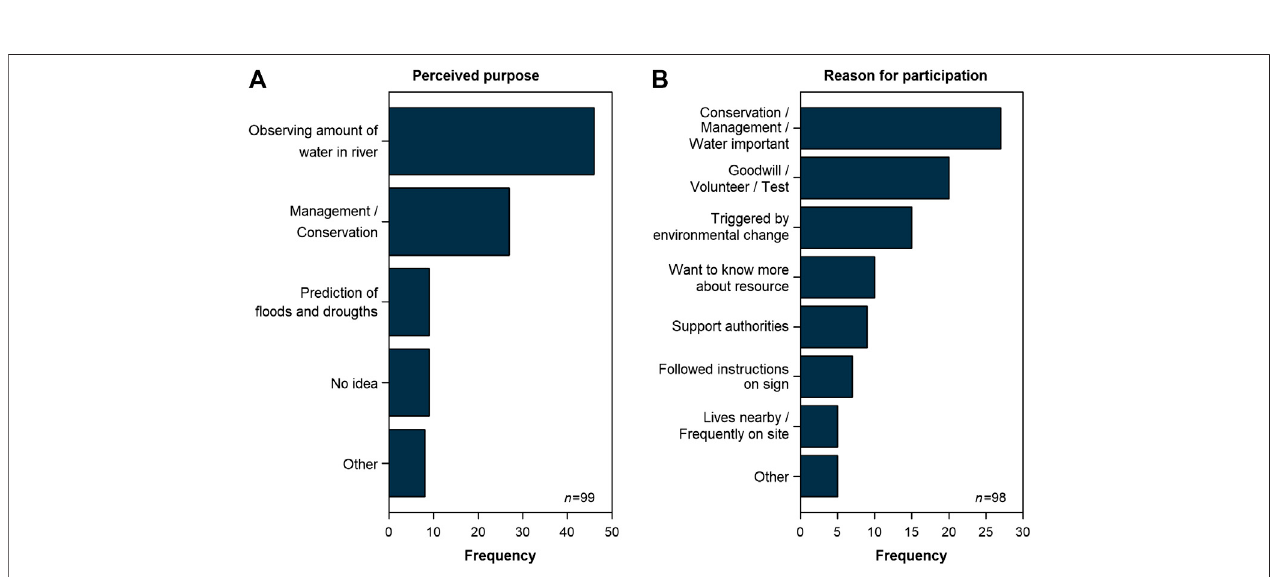
FIGURE4| Respondents ’ answerson (A) theperceived purpose ofthewatermonitoring projectand (B) theirreasontoparticipate ascitizen scientist. n (cid:2) number of responses.